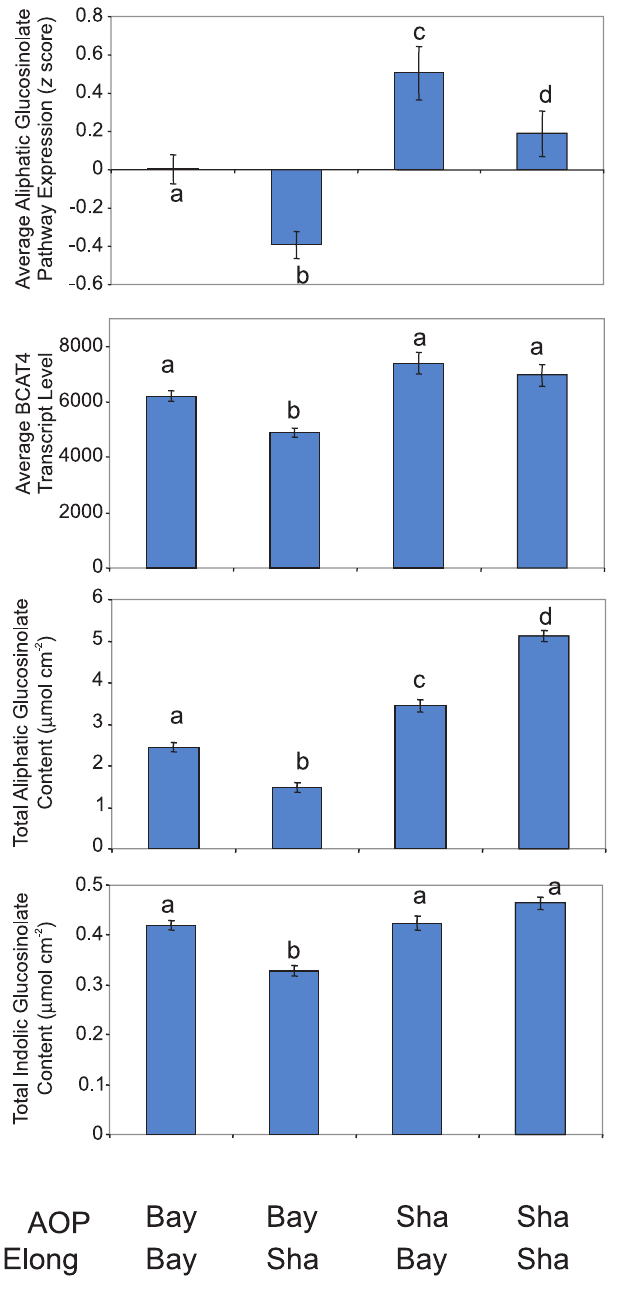
Figure 6. AOP and Elong Epistasis The Bay-0 3 Sha RILs were grouped by their GSL.AOP and GSL.Elong genotypes. The mean ( 6 standard error) for each group is presented for: (A) Mean z -score for the aliphatic glucosinolate biosynthetic pathway. (B) Transcript level for the BCAT4 gene. (C) Total aliphatic glucosinolate content. (D) Total indolic glucosinolate